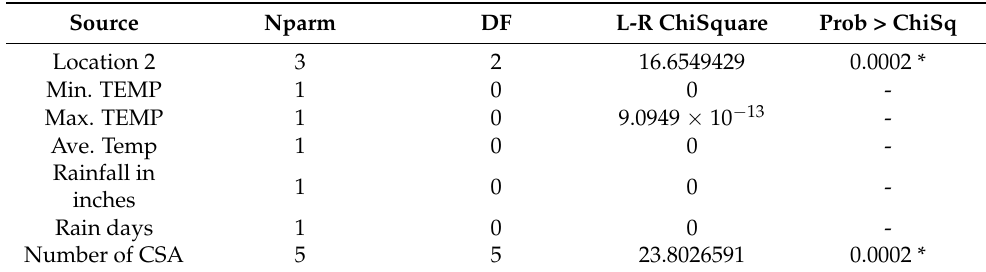
Table 4. Effect likelihood ratio test carried out to determine which factors influence the HDDS of households across all four